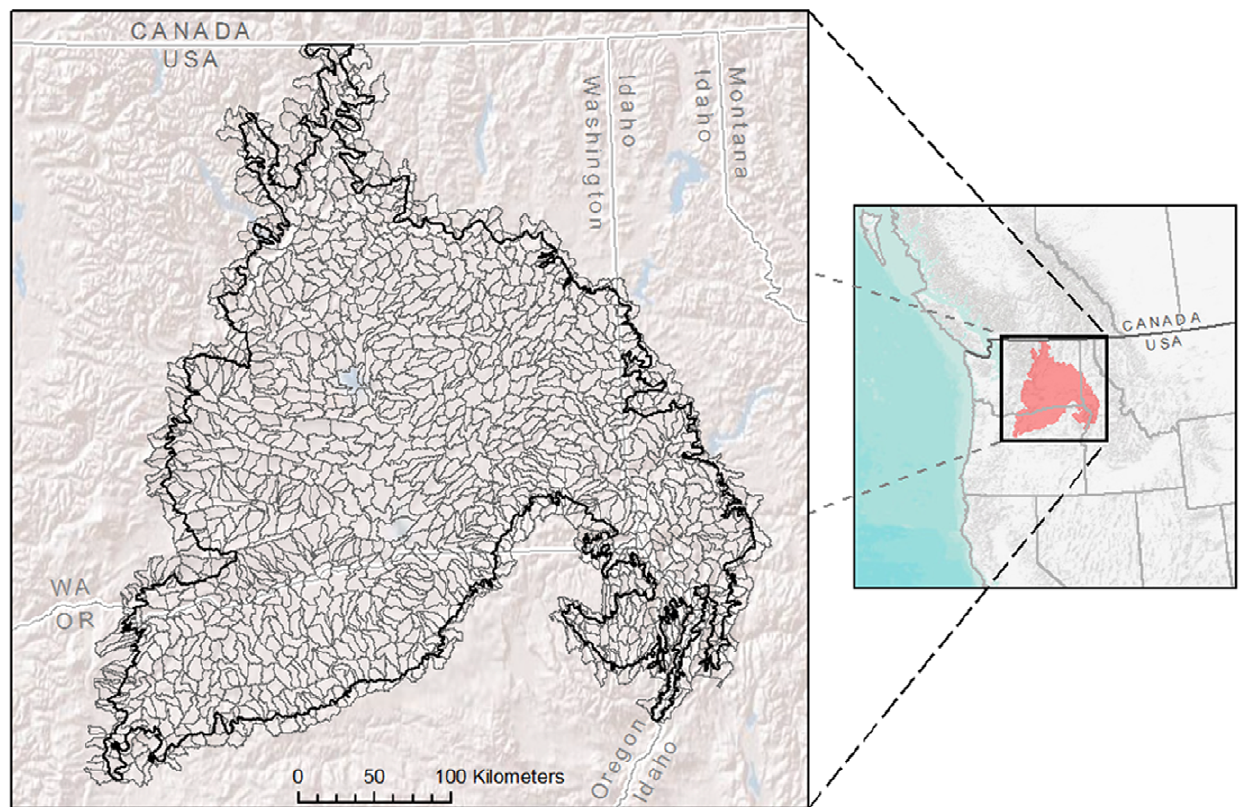
Figure 1. Columbia Plateau ecoregion. The map depicts 1200 hydrologic unit codes (HUC-12) that were used as conservation planning units in the present study.